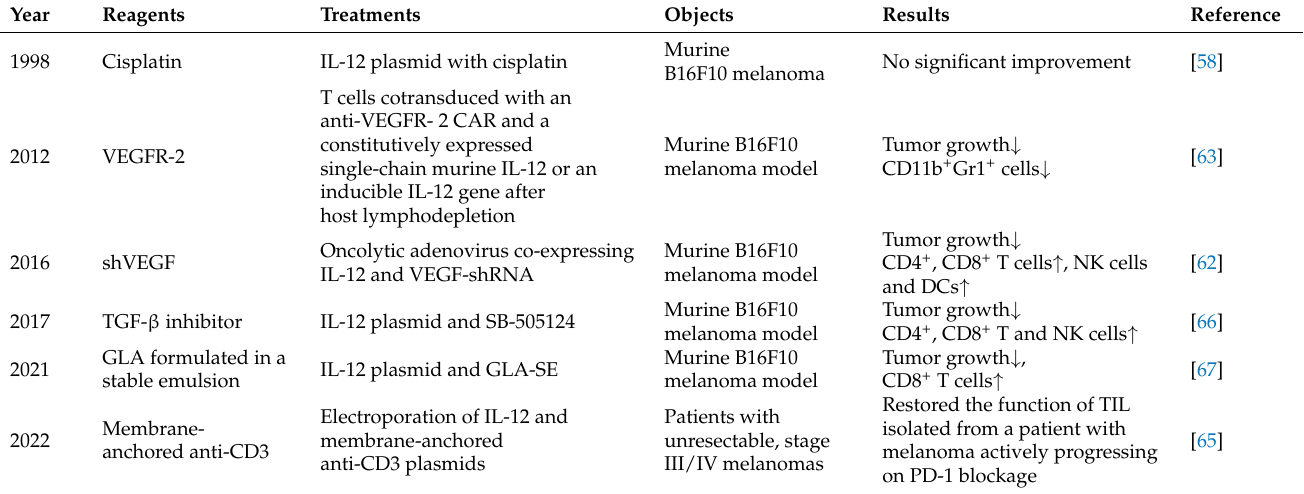
Table 4. IL-12 in combination with other therapeutic